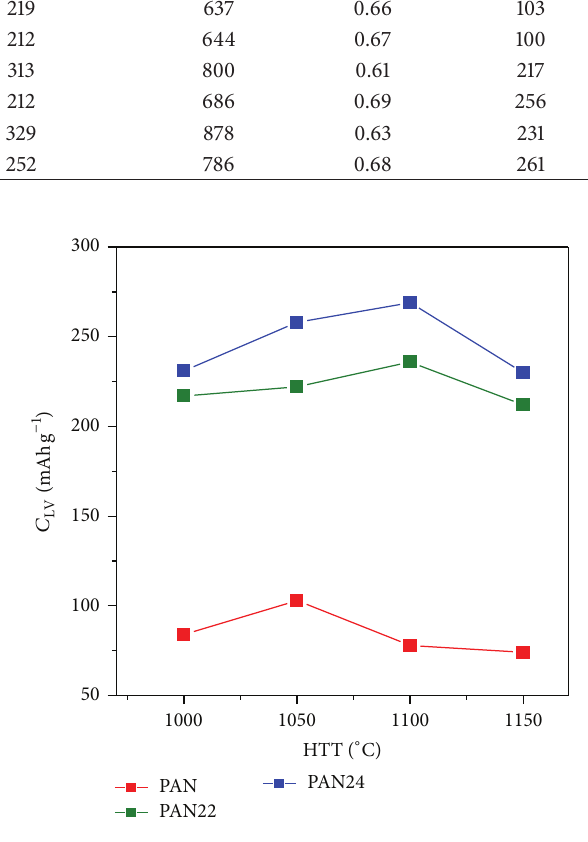
Figure 9: Variation of the low voltage reversible capacity with HTT of pristine and oxidized